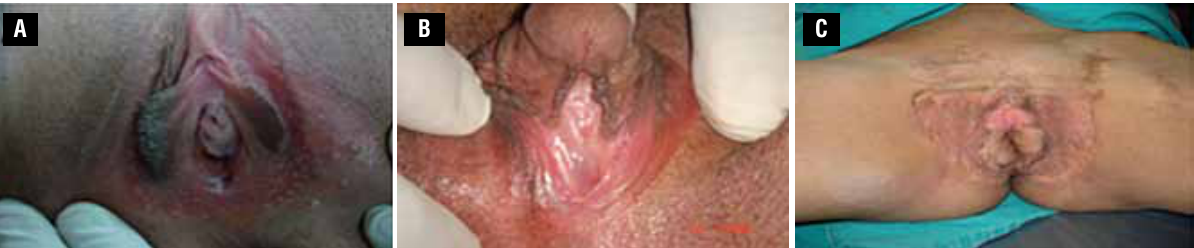
figure 3 A to c - Some preoperative diagnoses of studied groups. (A): a case of mullerian aplasia, (B): a case of incomplete androgen insensitivity syndrome and (c): a recurrent case with stenosed vagina and scarred perineum.